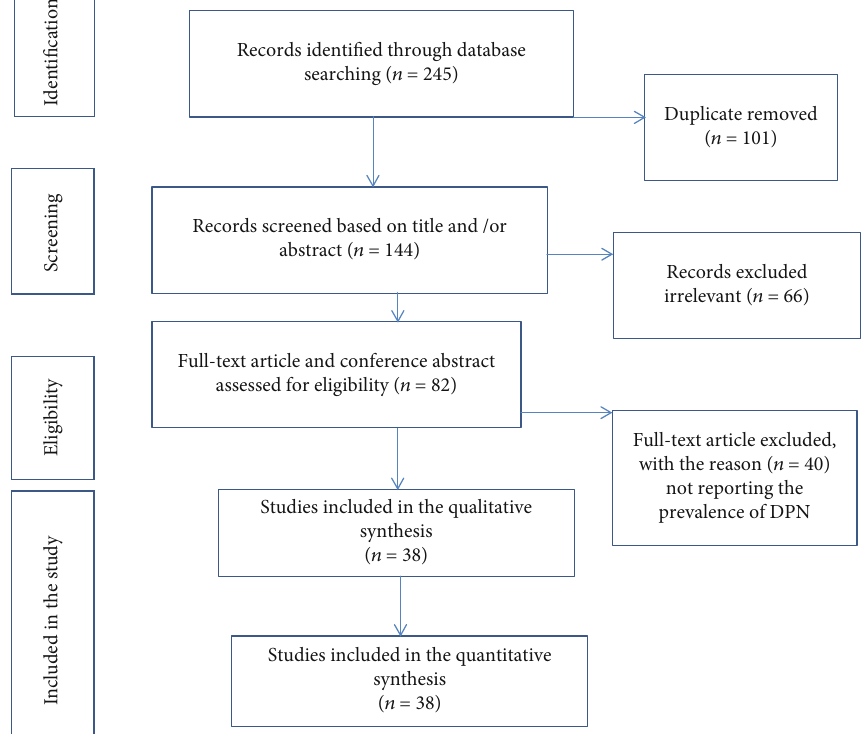
Figure 1: Flow chart diagram showing the selection of articles for systemic review and meta-analysis of DPN among patients with diabetes in Ethiopia,